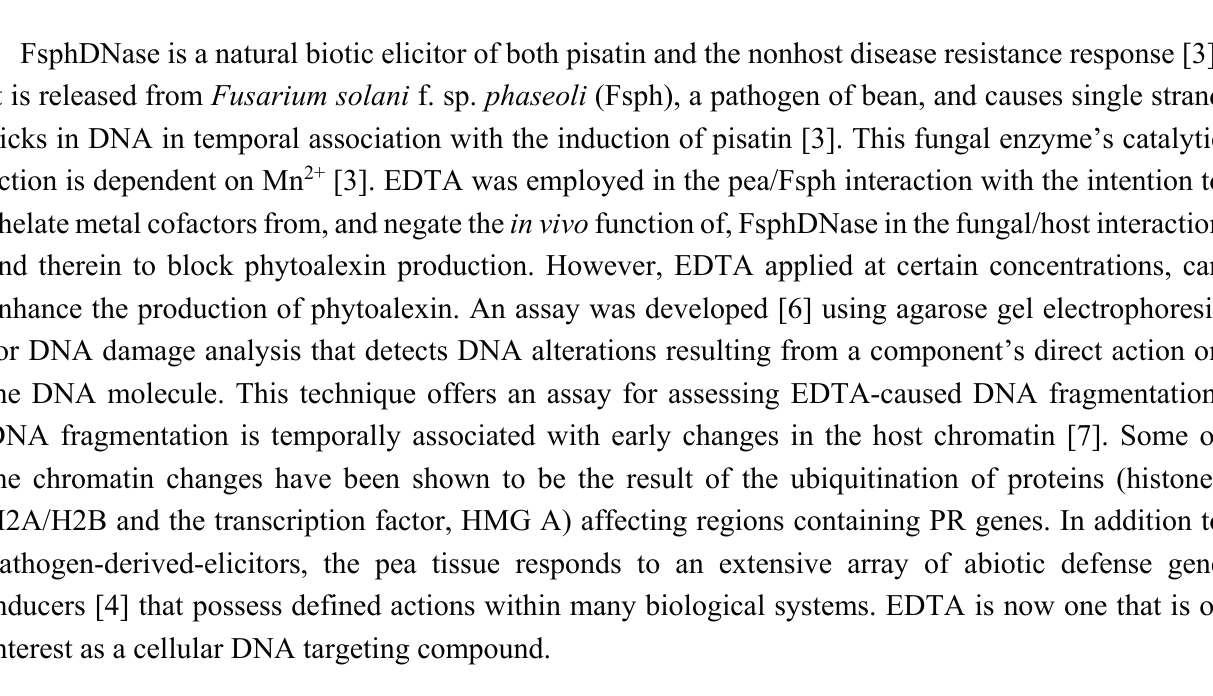
Figure 1. Structural formula of EDTA (ethylenediaminetetraacetic